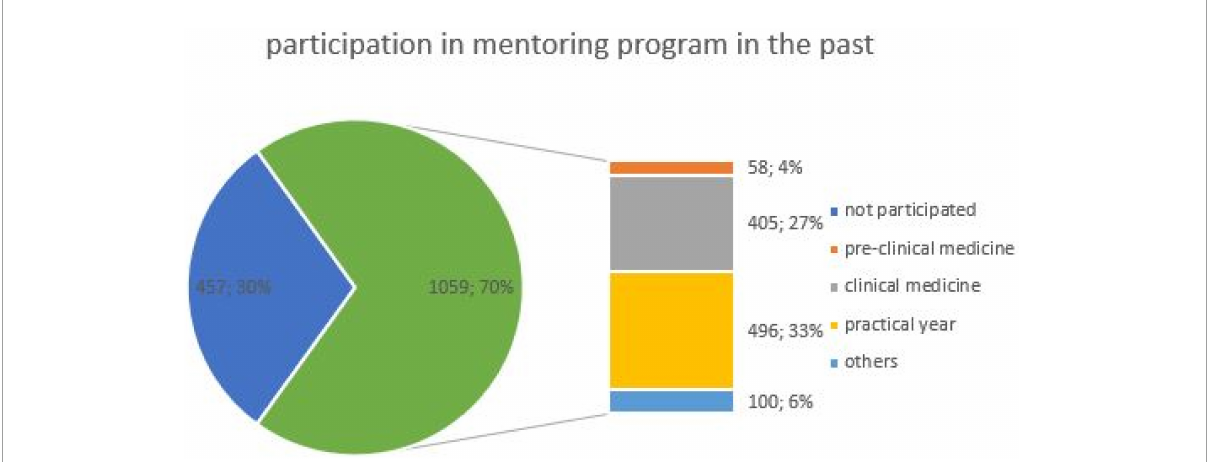
FIGURE2 Distribution of students who had participated in the mentoring program in the past in absolute numbers ( n = 1,516) and in percent. The figure is divided according to the participation mentoring program in the pie chart (blue: not participated, green: participated) and divided by study period in the bar chart.